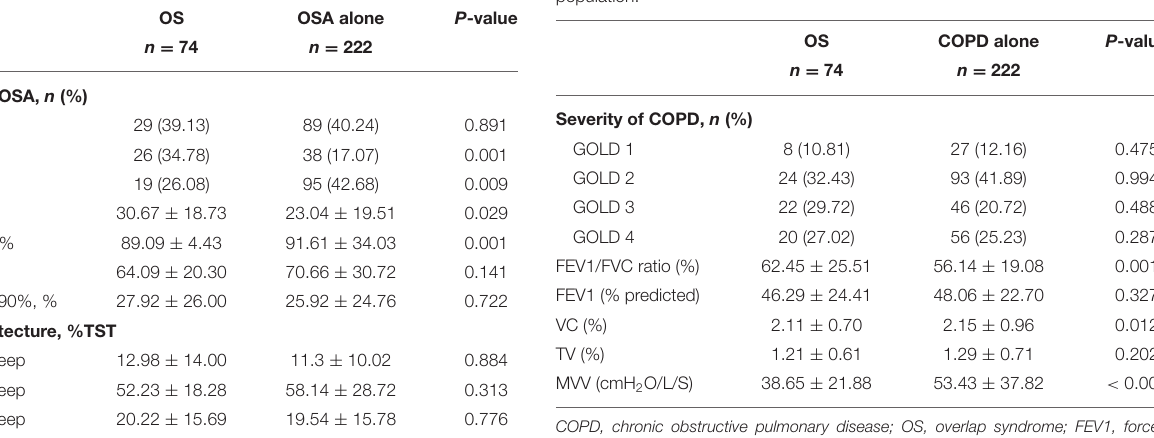
TABLE 3 | Pulmonary function tests and GOLD classification of the study population. OS COPD